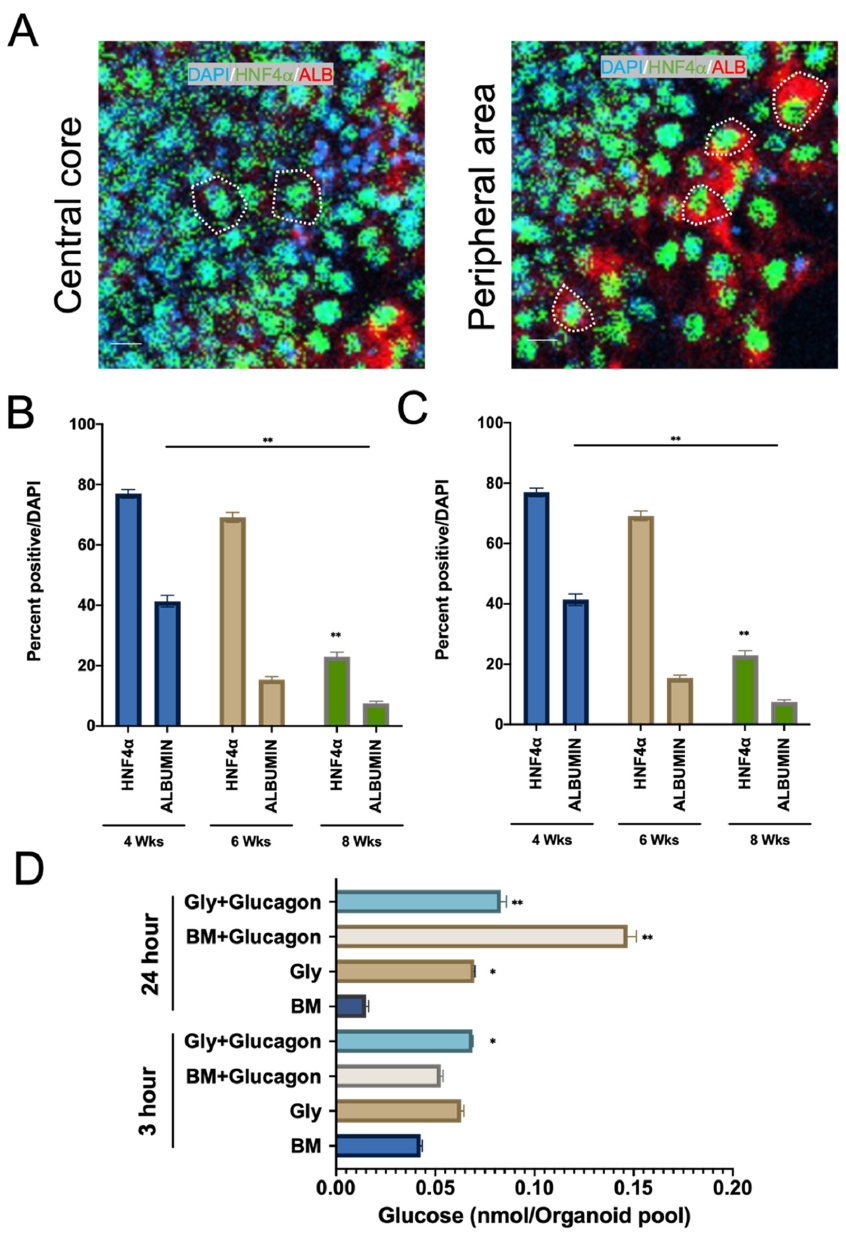
Figure 6. HepGOs show spatial distribution of HNF4 α and ALB-expressing cells and metabolic competence. ( A ) High power IF images showing the central core and the peripheral area of HepGOs at 8 weeks. Representative cells within the central core and peripheral area of the same organoid are outlined with white dotted lines. The typical nuclear DAPI (blue) and HNF4 α (green) overlay and cytosolic ALB (red) staining are outlined in the two zones. ( B , C ) Quantitation of expression of HNF4 α (green) and the functional marker ALBUMIN (ALB) in HepGOs at the indicated times. ( D ) Glucose production in HepGOs expanded in C6 EM supplemented with F + OSM. The HepGOs were starved for 3 or 24 h and then allowed to produce glucose for 24 h. The glucose production basal media (BM) was supplemented with either glycerol, glucagon, or a combination of the two. Data were obtained from pooled organoids with a total of ~70,000 organoid cells. Scale bar is 10 μ m. (** p < 0.01, * p < 0.05).